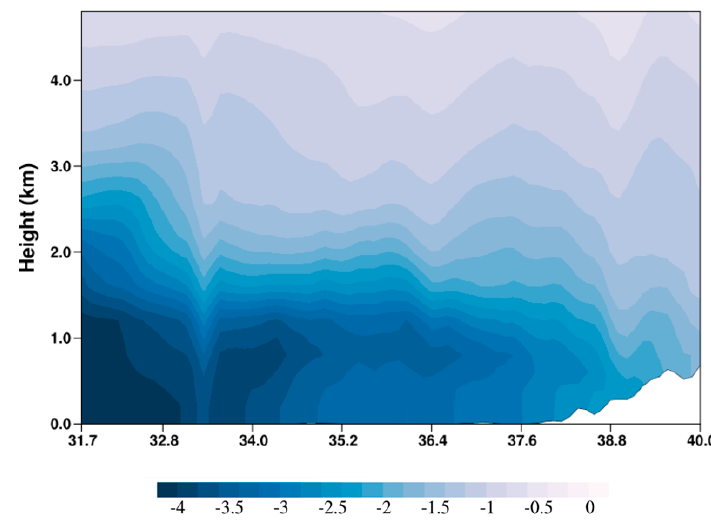
Figure 6. The changes in aerosol direct radiative effects (ADRE, Wm − 2 ) in South Korea due to the reduction of SO 2 emissions from foreign sources (R_FSO2–BASE).